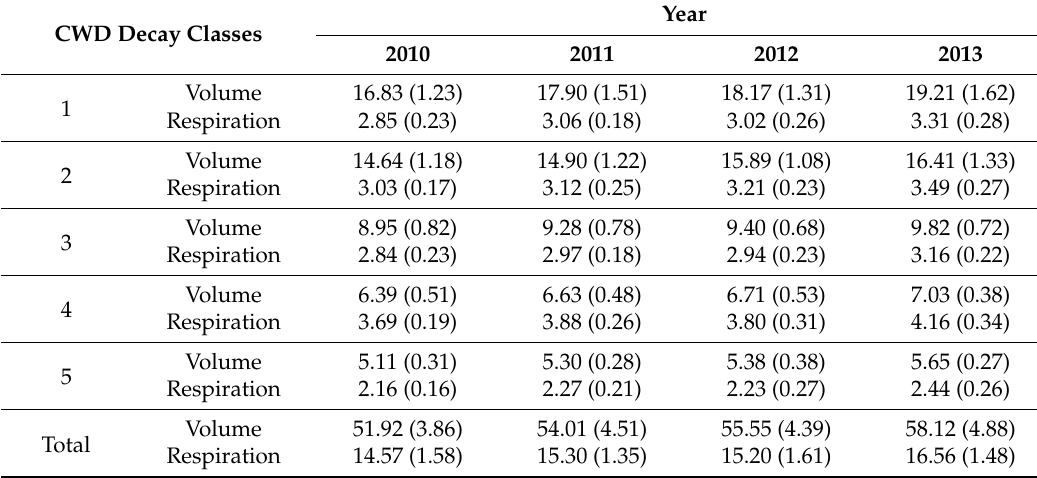
Table 2. Volume (m 3 · ha − 1 ) and the respiration of different coarse woody debris (CWD) decay classes per ground area (g · C · m − 2 · y − 1 ) during